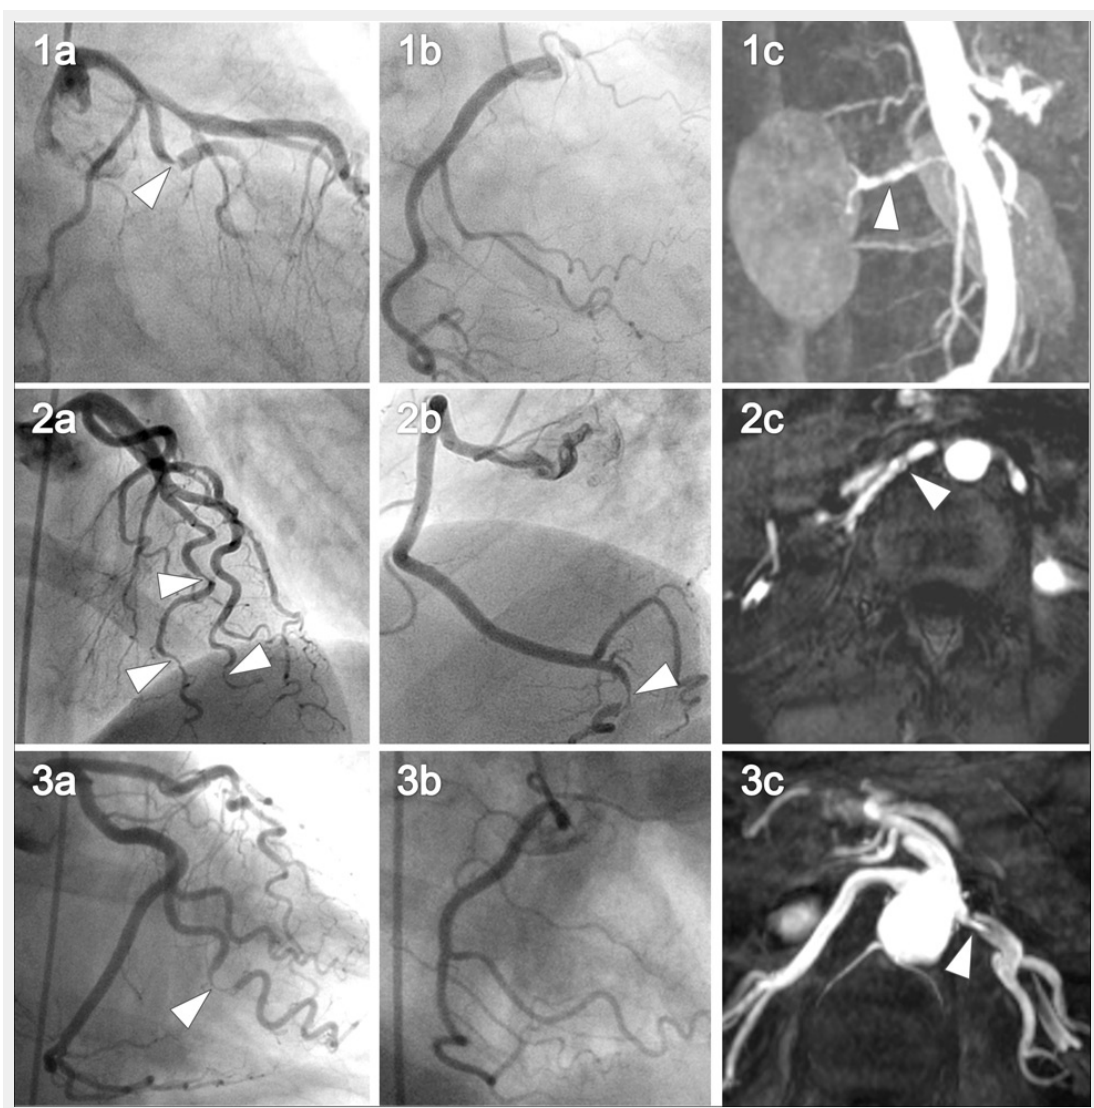
Figure 3 Coronary angiography and renal MR angiography of the 3 women with renal artery abnormalities. The left (images 1a, 1b, 1c) and right coronary (images 2a, 2b, 2c) angiography is shown for all three patients with the corresponding renal artery abnormalities (images 3a, 3b, 3c). Arrows in images 1a–c and 2a–c point at spontaneous coronary artery dissections. Arrows in images 3a–c point at renal artery fibromuscular dysplasia (3a, 3b) and renal artery dissection